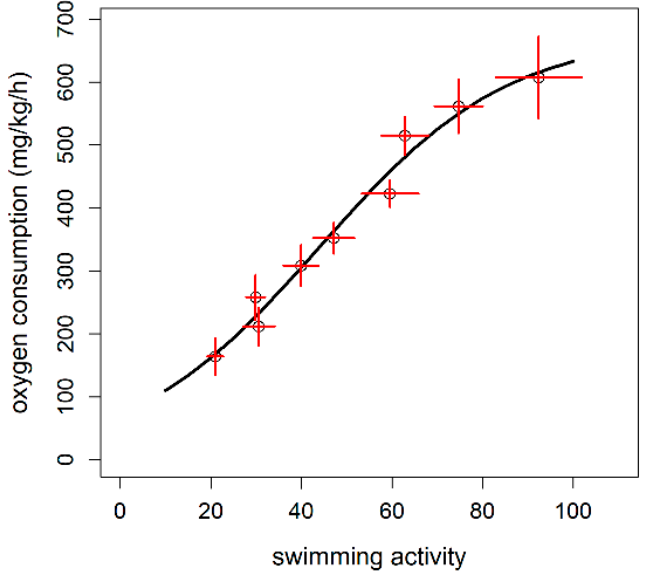
Figure 5. Logistic model of the oxygen consumption rate (MO 2 ) as a function of the swimming activity monitored by means of the accelerometer tags in rainbow trout ( Oncorhynchus mykiss ). The estimated parameters of the logistic model were as follows: A sym = 675 ± 54.26; x mid = 43.98 ± 4.23; scal = 20.78 ± 3.31 (n = 10 fish; mean ± standard error).